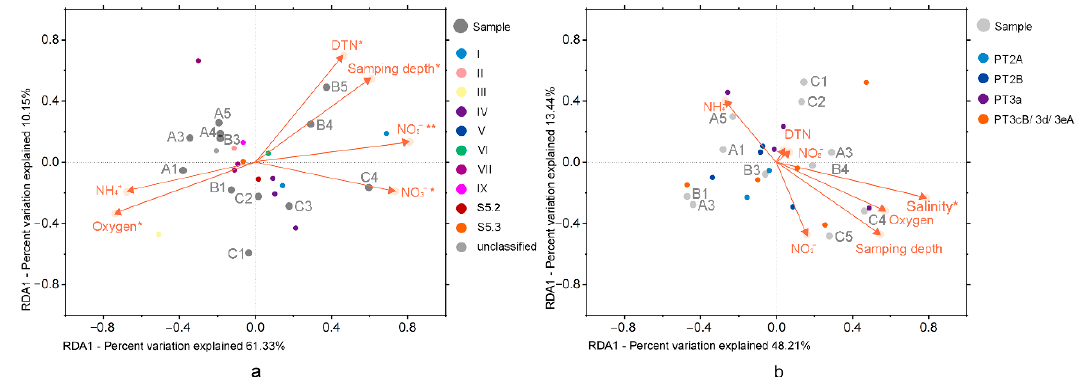
Figure 4. Correlation plots based on a redundancy analysis (RDA), revealing the relationship between samples, environ- mental factors, and the 15 most abundant OTUs based on rpo C1 gene ( a ) and cpe BA operon ( b ). “*” indicates p < 0.05, “**” indicates p < 0.01.